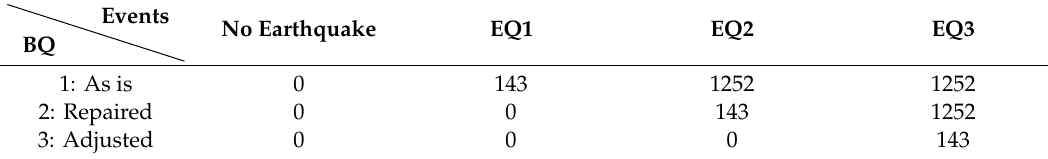
Table 10. Costs expressed in € / m 2 due to seismic event occurrence and building quality.